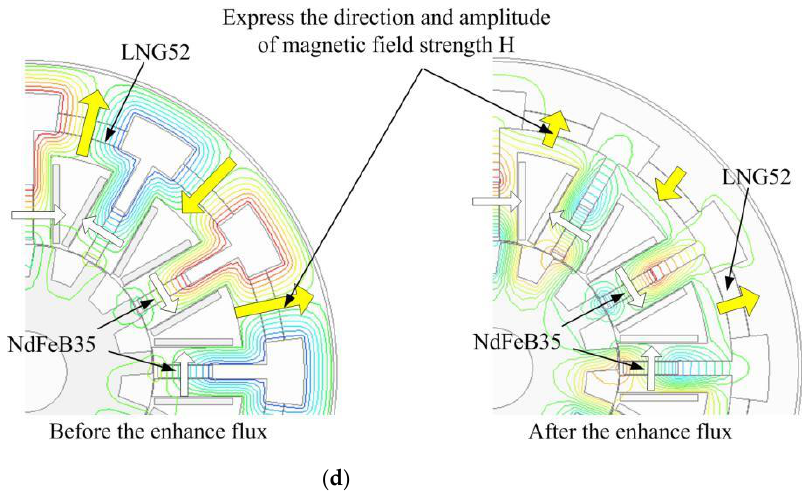
Figure 12. Detailed analysis of mutual demagnetization effect in VFMPM machine. ( a ) Variation of magnetic flux density (B); ( b ) Variation of magnetic field strength (H); ( c ) Key variation of magnetic flux density (B) and magnetic field strength (H); ( d ) Decrease of magnetic field strength of LNG52.